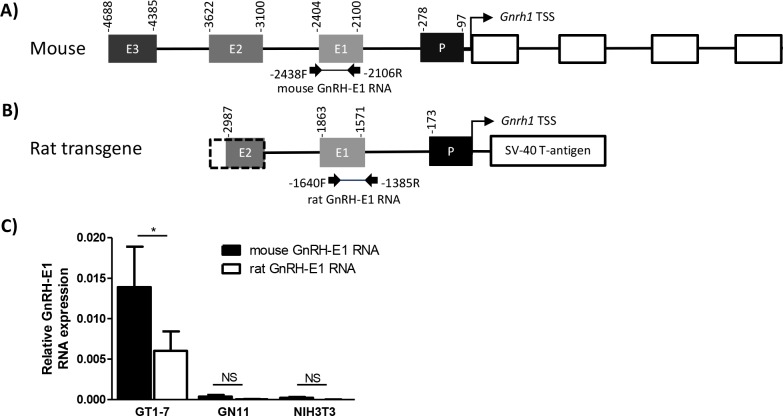
RT-qPCR analysis of rat and mouse GnRH-E1 RNA expression in cell lines.(A) A schematic diagram of conserved regulatory elements upstream of the mouse Gnrh1 transcription start site (TSS, curved arrow) and Gnrh1 gene coding region. The Gnrh1 gene regulatory region contains Gnrh1 enhancers 1, 2, and 3 (E3, E2, E1, respectively), the promoter (P), and the Gnrh1 gene consists of four exons (white boxes). PCR primers used in Fig 2C are indicated by arrows, and the predicted PCR product mouse GnRH-E1 RNA is represented by a connecting line. (B) Schematic diagram of transgene embedded in GT1-7 neurons carrying the 3’ portion of the rat GnRH-E2, GnRH-E1, GnRH-P, and the Gnrh1 TSS, driving the SV40 T-antigen oncogene. PCR primers used in Fig 2C are indicated by arrows, and the predicted PCR product rat GnRH-E1 RNA from the transgene is represented by a connecting line. (C) RT-qPCR analysis of endogenous mouse GnRH-E1 RNA (black) and GnRH-E1 RNA expressed from the rat Gnrh1 promoter transgene (white) in GT1-7, GN11, and NIH3T3 cells. Relative GnRH-E1 RNA expression is normalized to peptidylprolyl isomerase A (Ppia) mRNA control. Data are displayed as means ± SD. Asterisk indicates statistical significance by Student’s T-test on the comparison between mouse and rat GnRH-E1 RNA, where p<0.05.